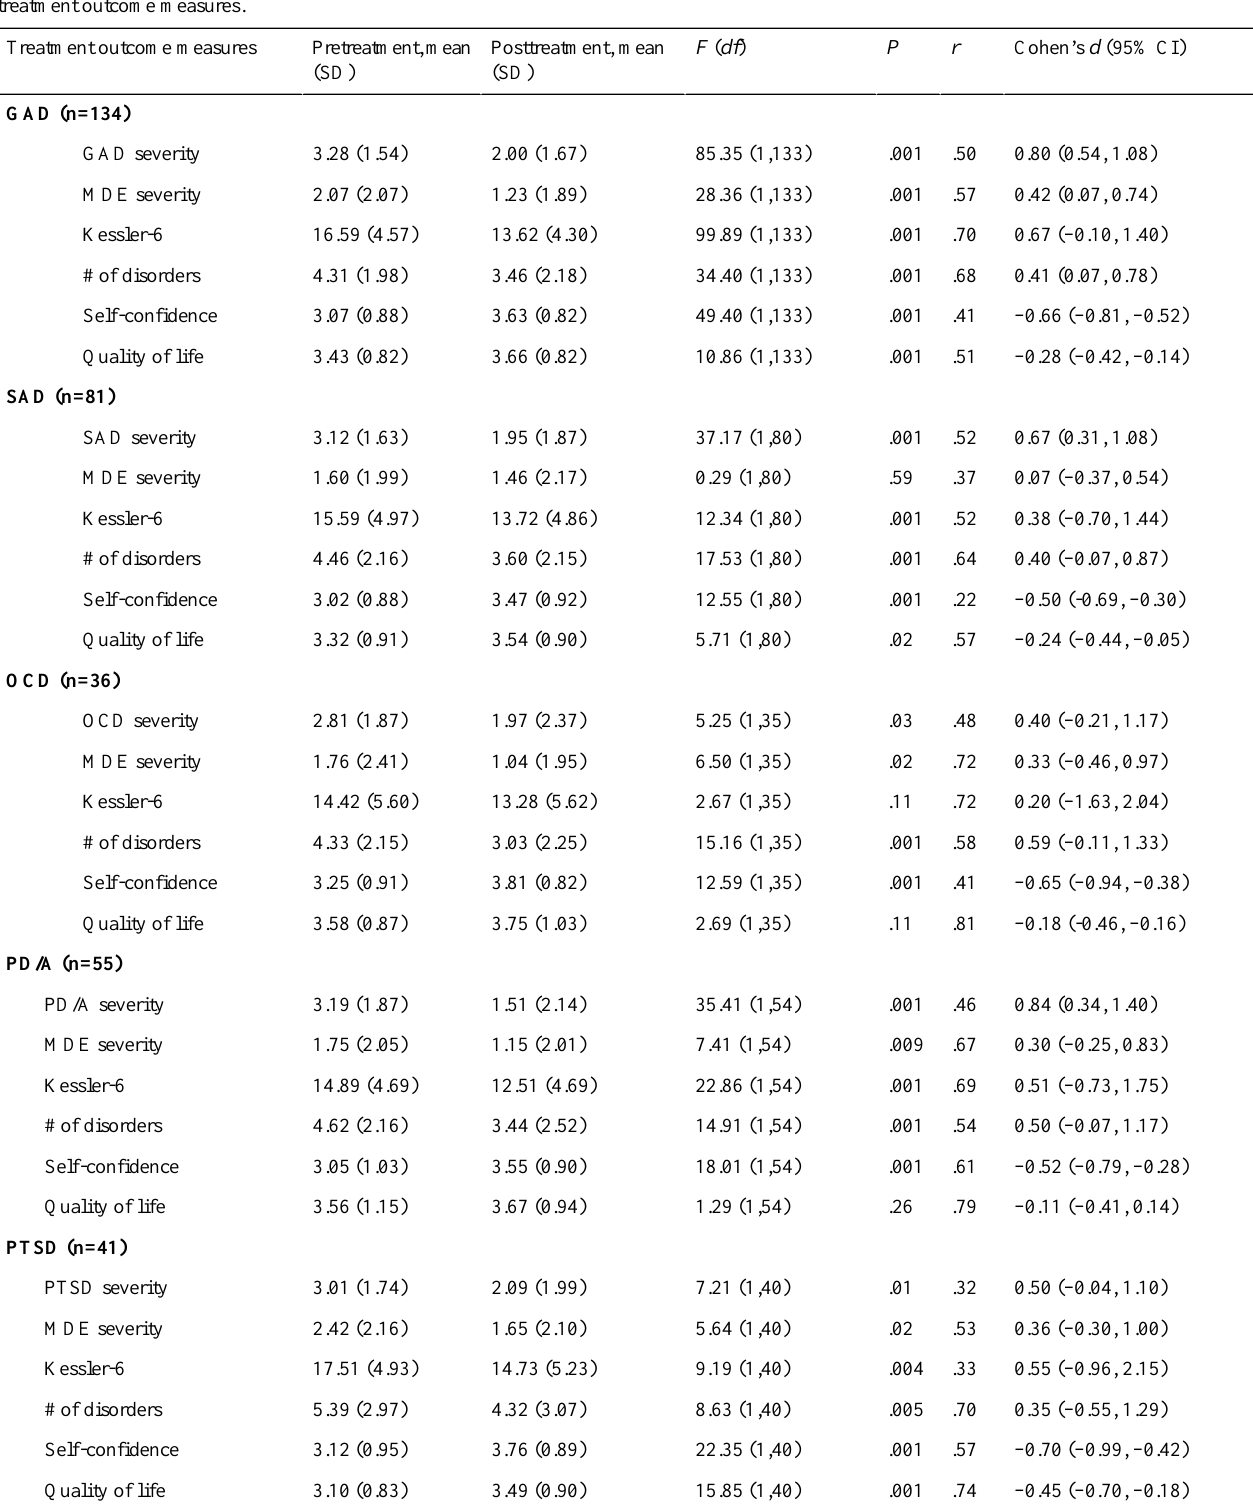
Table 4. Summary of means, standard deviations, correlations for pre- and posttreatment results, F values, P value, and Cohen’s d and its 95% CI for treatment outcome